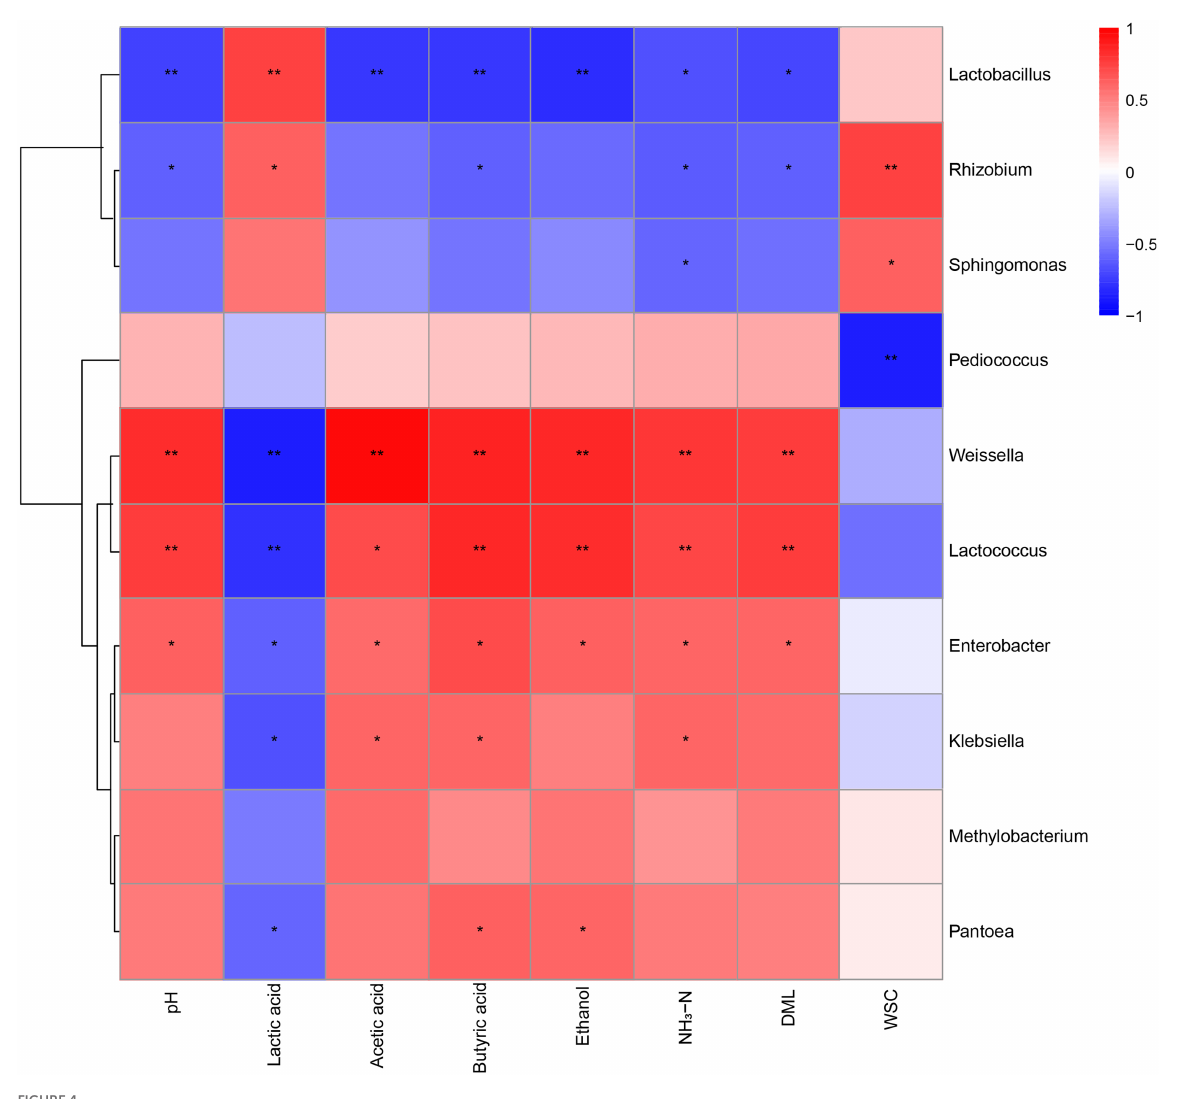
FIGURE 4 Heatmap of Spearman correlation analysis of bacterial community composition and fermentation parameters. CK, no additives; LA, laccase; PL, Pediococcus pentosaceus ; LPL, laccase + Pediococcus pentosaceus . *0.01 < p < 0.05; ** p < 0.01. NH 3 –N, ammonia nitrogen; DML, dry matter losses; WSC, water-soluble